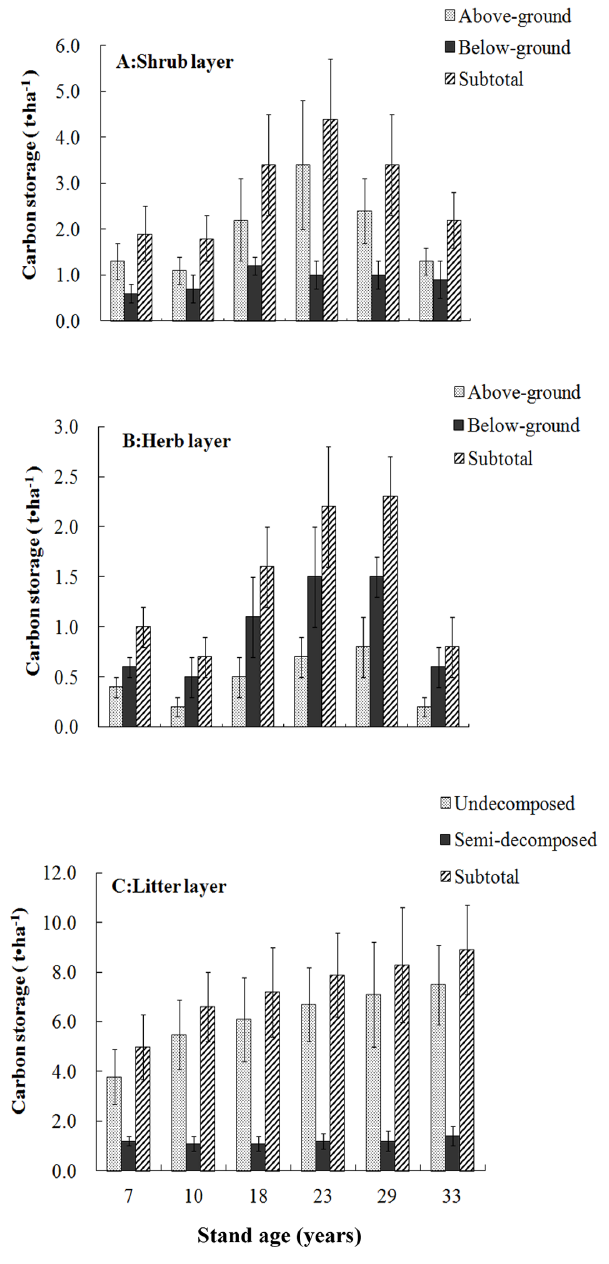
Figure 2. Carbon stocks in the shrub, herb and litter layers in six differently aged Mytilarialaosensis stands. Values are means 6 SE, n=4.